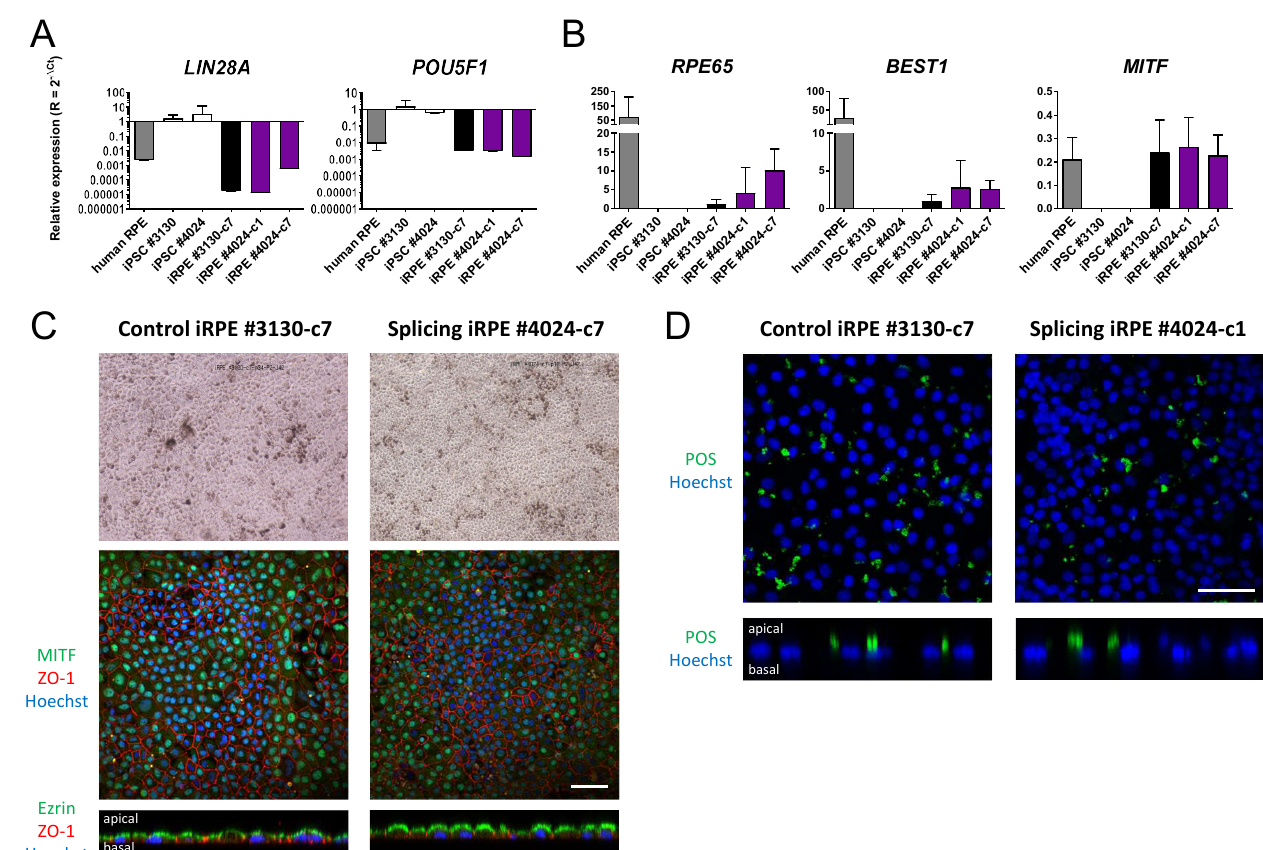
Figure 3. Characterization of iPSC-derived retinal pigment epithelium. ( A ) Quantitative RT-PCR analysis of the expression of stem cell markers LIN28A and POU5F1 . The data were normalized to 18S rRNA expression; ( B ) quantitative RT-PCR analysis of the expression of retinal pigment epithelium (RPE) specific markers RPE65 , BEST1 and MITF. The data were normalized to 18S rRNA expression; ( C ) phase-contrast images of pigmented iPSC-derived RPE (iRPE) cells (upper panel) and immunofluorescent staining (lower panels) of RPE markers MITF in the nucleus, ZO-1 at tight junctions with orthogonal view of ezrin and ( D ) confocal images with orthogonal view of internalized FITC-conjugated POS in iRPE cells from clones #3130-c7 and #4024-c1 after 5 h of phagocytosis. Nuclei were stained with Hoechst 33342. Scale bar: 50 µ